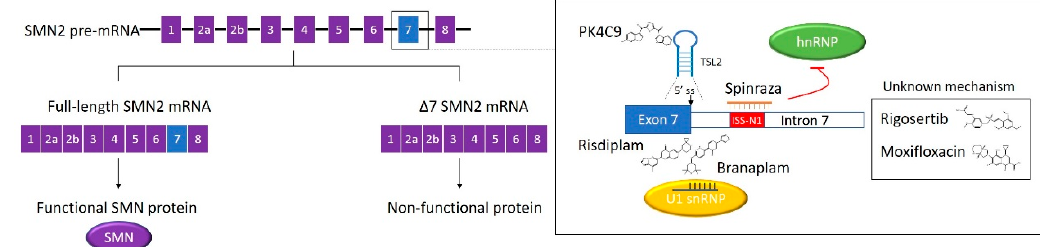
Figure 2. RNA-targeted therapy of SMA. The exons of SMN2 pre-mRNA are shown as squares and introns as lines. Alternative splicing with exon 7 inclusion generates full-length SMN2 mRNA and functional protein, while the loss of exon 7 results in non-functional protein. The junction between exon 7 and intron 7 is enlarged. SMN2 splicing modifiers and the working mechanisms are indicated. Spinraza is an approved ASO drug binding at ISS-N1, preventing the hnRNP interaction. Risdiplam and branaplam stabilise the U1 snRNP binding to the 5’ss of exon 7. PK4C9 acts at TSL2, a secondary structure at the exon 7 / intron 7. Rigosertib and moxifloxacin correct SMN2 splicing with unknown mechanisms.